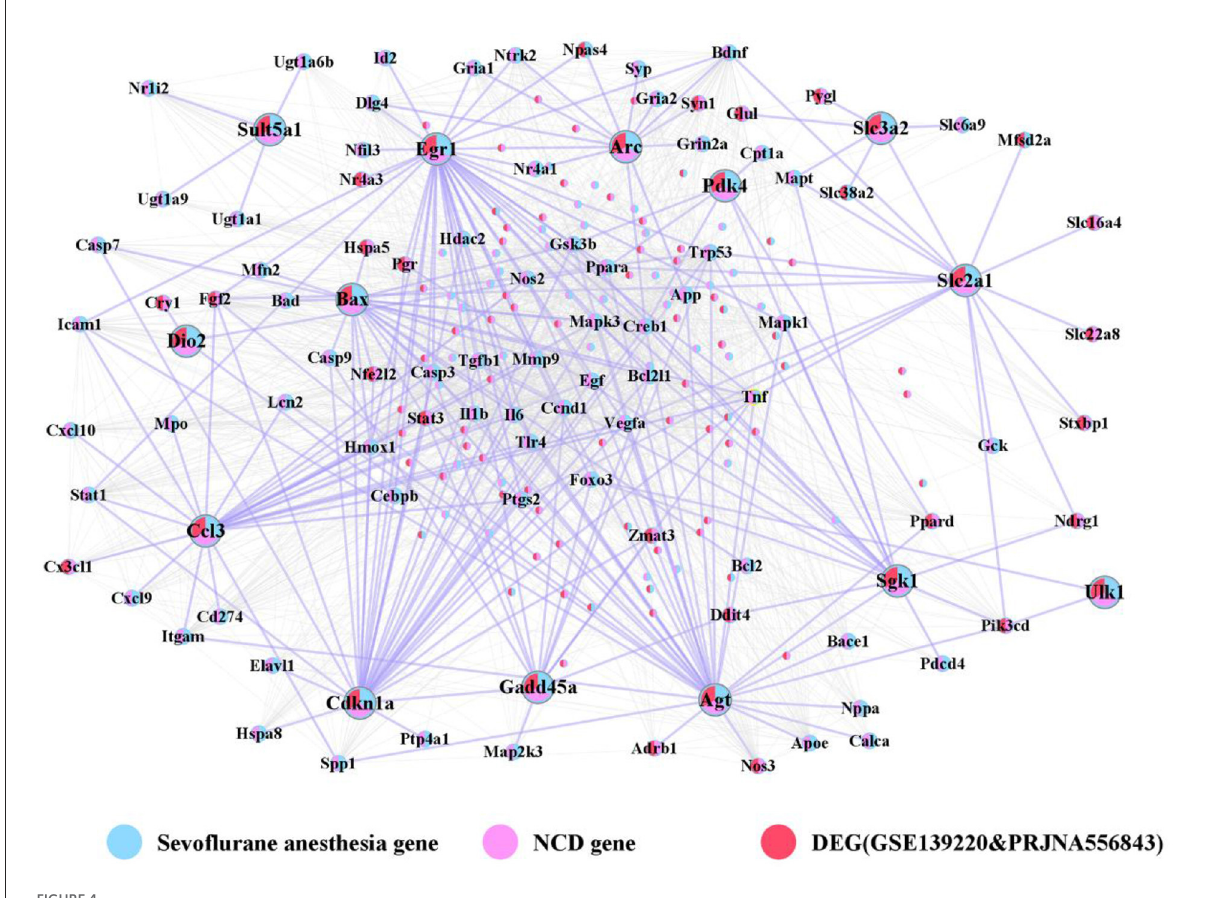
FIGURE4 Cross talk gene PPI network. The network contains 210 nodes and 1,842 edges.